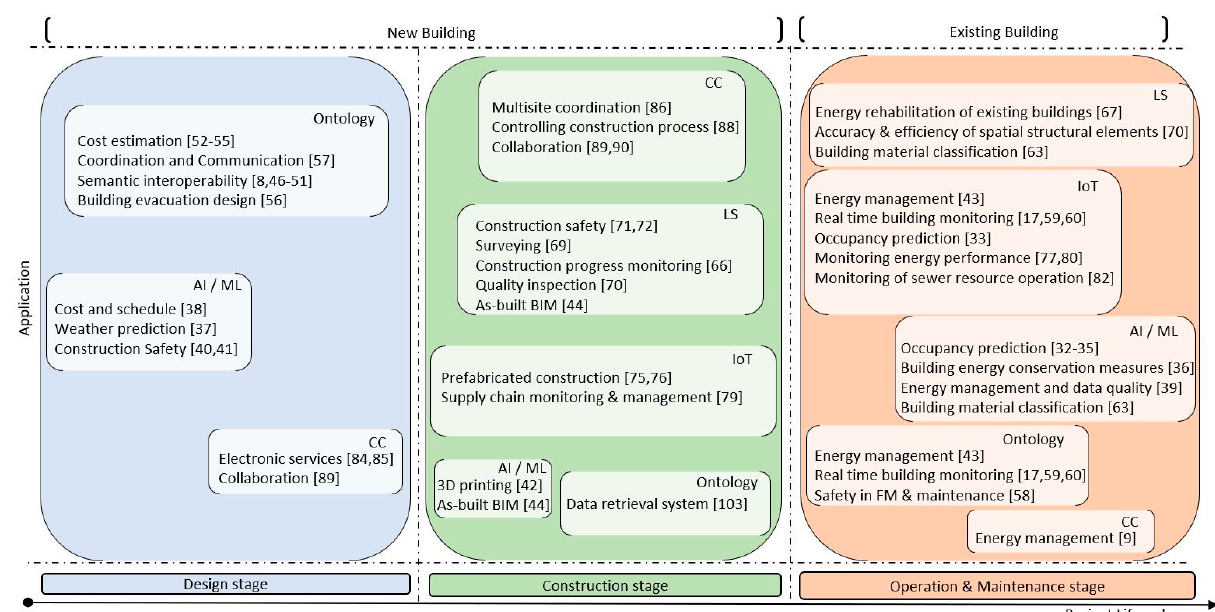
Figure 3. Existing research into technology immersion in the project